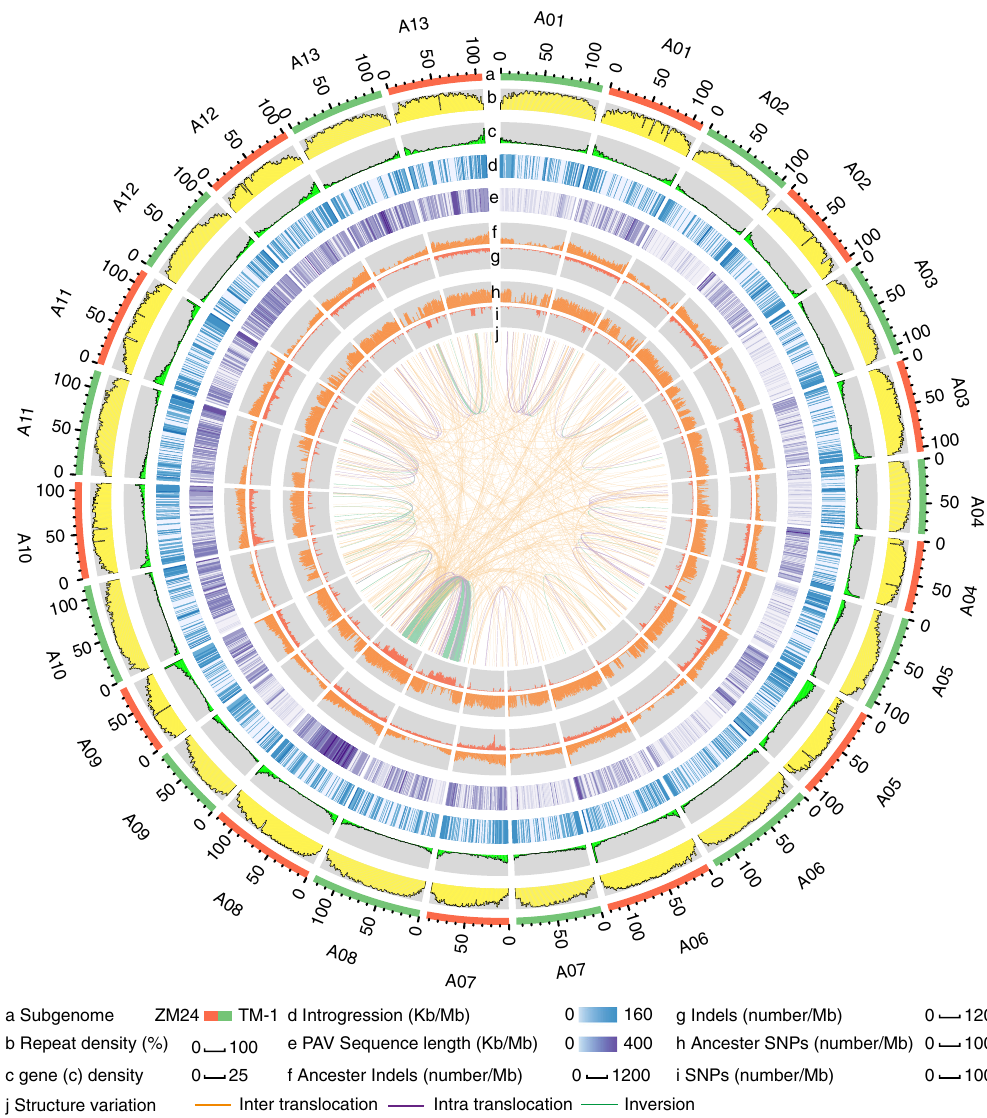
Fig. 2 Genomic landscape between TM-1 and ZM24 genomes. a Subgenomes of TM-1 (green) and ZM24 (orange). b , c Transposable elements and gene density in 1 Mb sliding windows. d Introgression from chromosomes of the D t subgenome to its counterpart chromosomes in the A t subgenome in 1 Mb sliding windows. e Distribution of PAV sequences in 1 Mb sliding windows. f InDels between the TM-1 and ZM24 A t subgenomes and G. arboreum (A 2 ) in 1 Mb sliding windows. g InDels between TM-1 and ZM24 A t subgenomes in 1 Mb sliding windows. h SNPs between A t subgenomes and A 2 in 1 Mb sliding windows. i SNPs between TM-1 and ZM24 A t subgenomes in 1 Mb sliding windows. j Large-scale variations between the TM-1 and ZM24 subgenomes. Source data are provided in a Source Data fi le